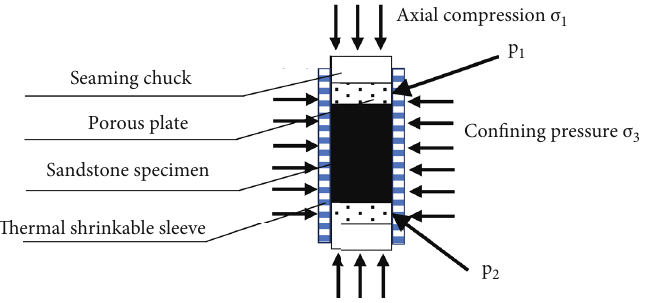
Figure 1: Sketch of permeability experiment